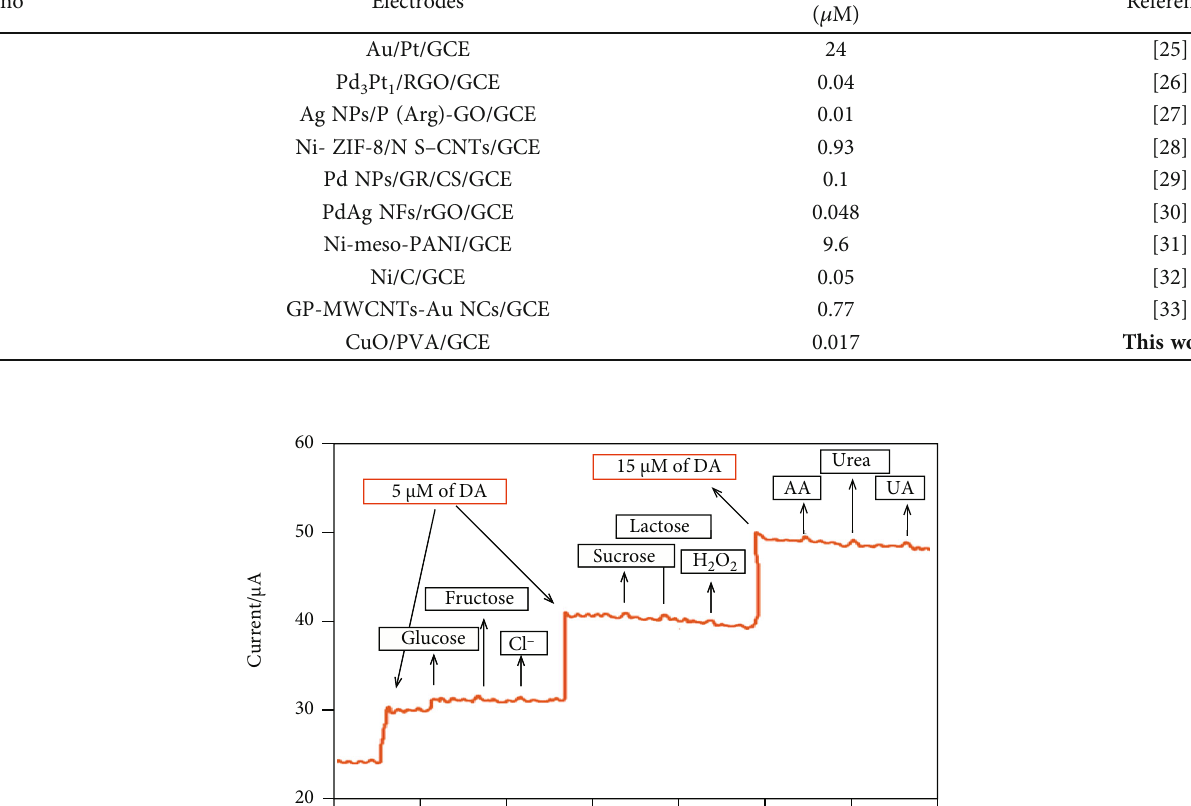
Table 1: Assessment of sensing action of the CuO/PVA/GC electrode with other fabricated electrodes. S. no